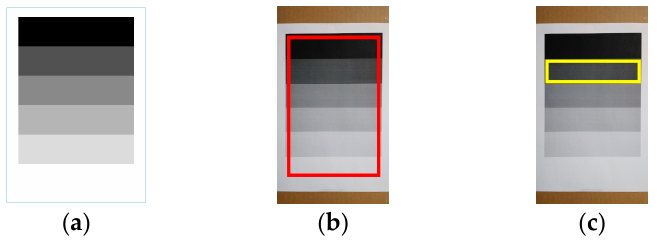
Figure 4. Stripe plane pattern with different grayscales printed on A4 paper: ( a ) stripe plane pattern on A4 paper; ( b ) red box region; and ( c ) yellow box region.